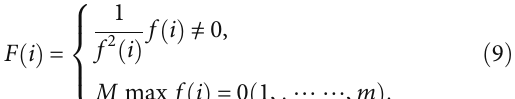
Immune genetic garlic